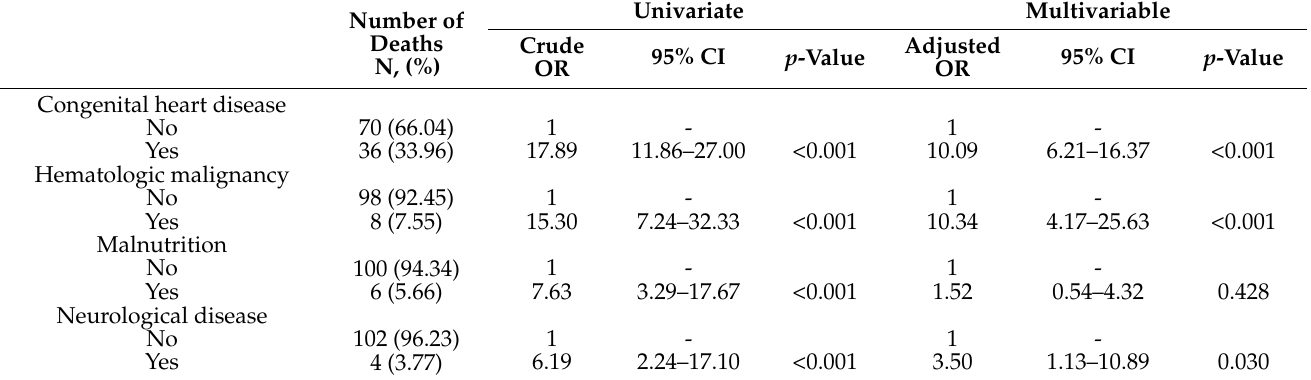
Table 5. Factors associated with mortality among hospitalized children with RSV-related